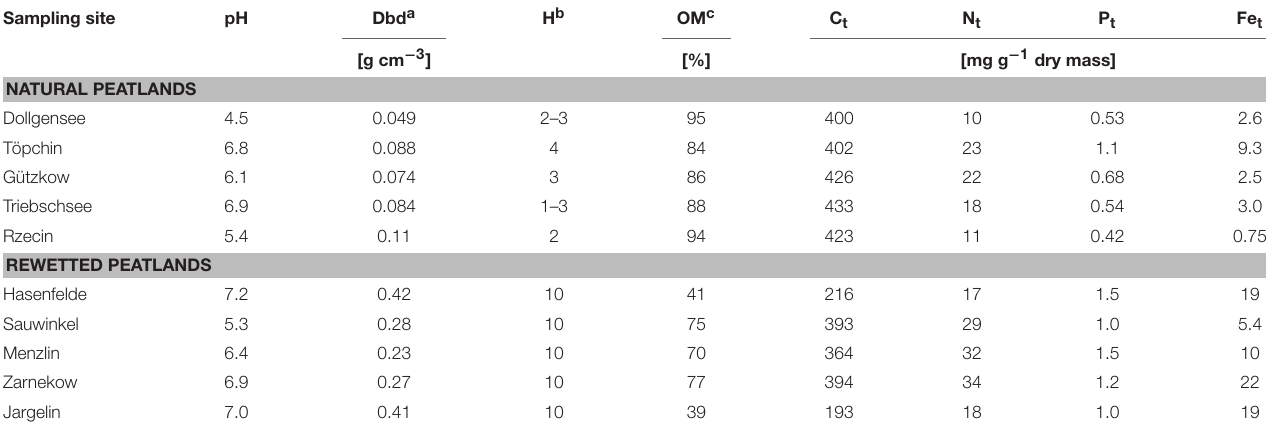
TABLE 2 | Selected peat characteristics of sampling sites: (C t , N t , P t , and Fe t –total contents of carbon, nitrogen, phosphorus, and iron), dry bulk density (Dbd) calculated from the dry matter according to Scheffer and Blankenburg (1993), the degree of peat decomposition (H) according to von Post-scale (Von Post, 1922) and organic matter (OM) in % of dry matter determined by loss on